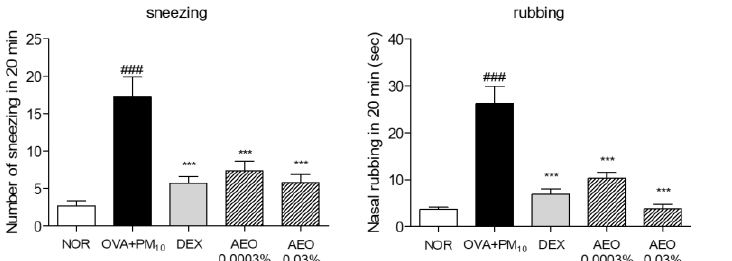
Figure 3. AEO decreased the frequency of sneezing and rubbing behavior in OVA+PM 10 -induced allergic rhinitis mice. The number of sneezing and rubbing was counted for 20 min through watching by a fiver observer and recorded with the video. The data are presented as the means ± standard error of the mean. ### p < 0.001 compared to the NOR group. *** p < 0.001 compared to OVA+PM 10 group.